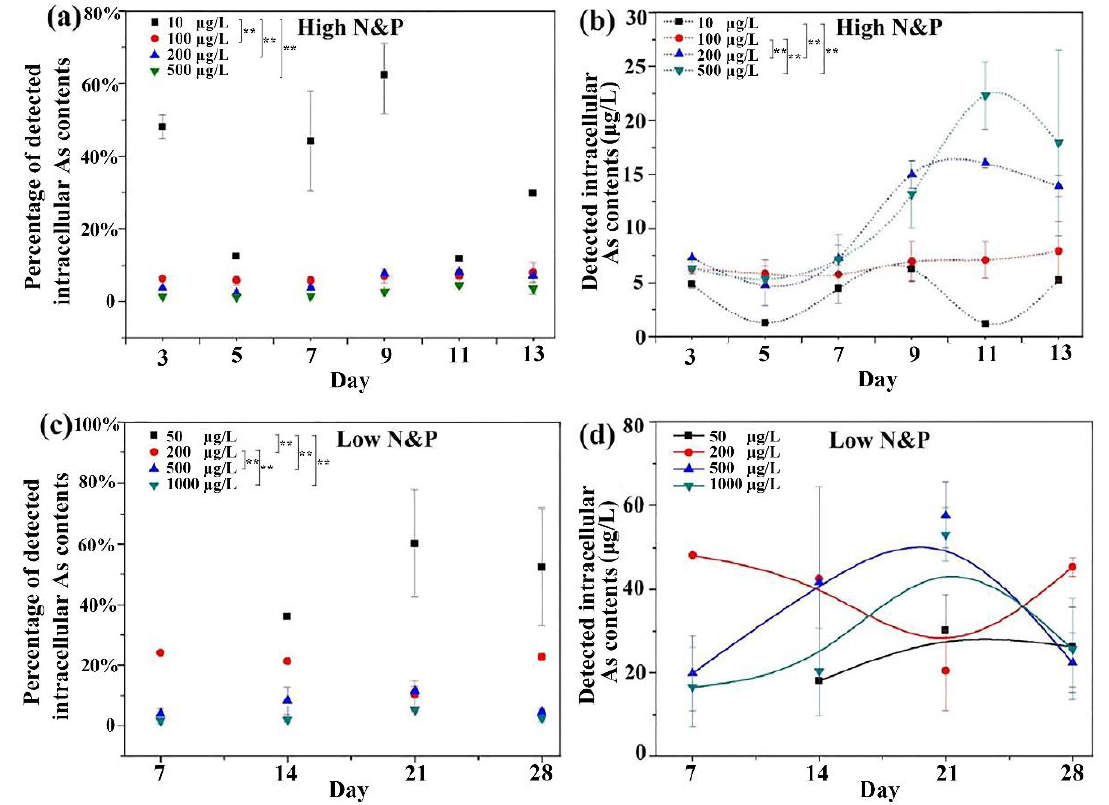
Figure 4. The percentage of detected intracellular As content in the total added iAs(V) concentration, and their concentration (mg/L) varied with incubation time that exposed different iAs(V) concentra- tions in the high ( a , b ) and low ( c , d ) nutrient sets. Note: The percentage of detected intracellular As contents, and their concentrations with incubation time were compared between each of two groups of ambient iAs(V) concentrations. Significance levels below 0.01 (**) are denoted in the fig- ure.